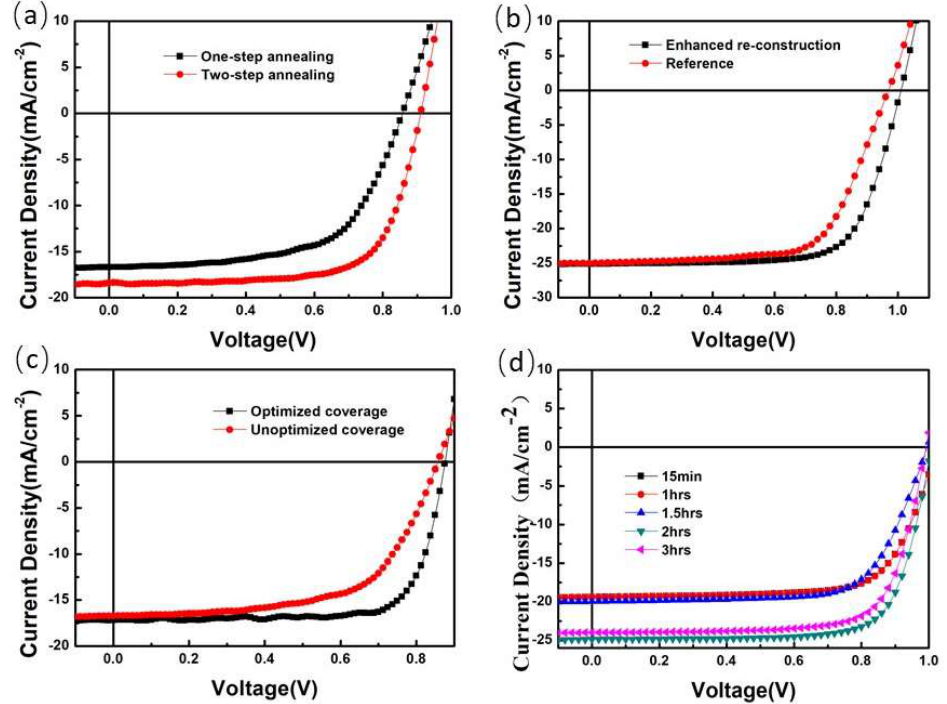
Figure 3. The two-step annealing procedure fabricated perovskite solar cell (PSC) [2] ( a ), optimizing annealing time fabricated PSC [16] ( b ), optimizing annealing time fabricated PSC [17] ( c ), optimizing film morphological fabricated PSC [18] ( d ).